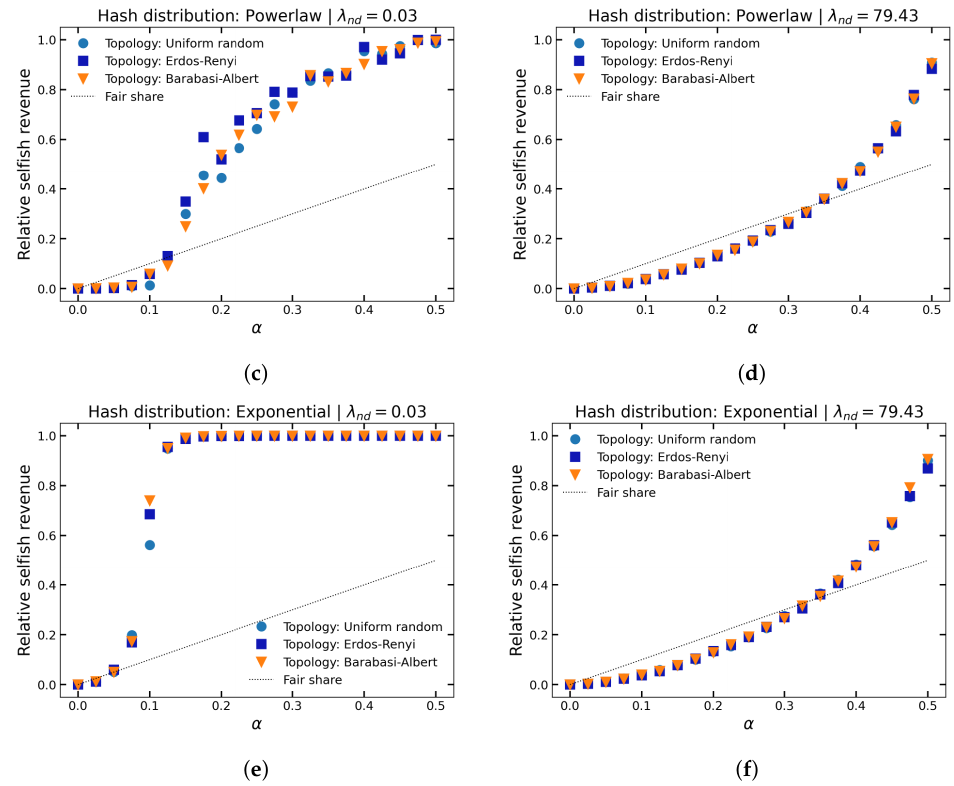
Figure 3. Relative selfish revenue as a function of selfish hashing power ( α ) under different distribu- tion: ( a , b ) in which the hashing powers of all miners follow the uniform distribution; in ( c , d ) miners’ hashing powers follow the power-law distribution; and in ( e , f ) miners’ hashing powers follow the exponential distribution. In addition, the subfigures in left column show the results when network has very high latency λ nd = 0.03, and those in right column show the results with low network latency λ nd =